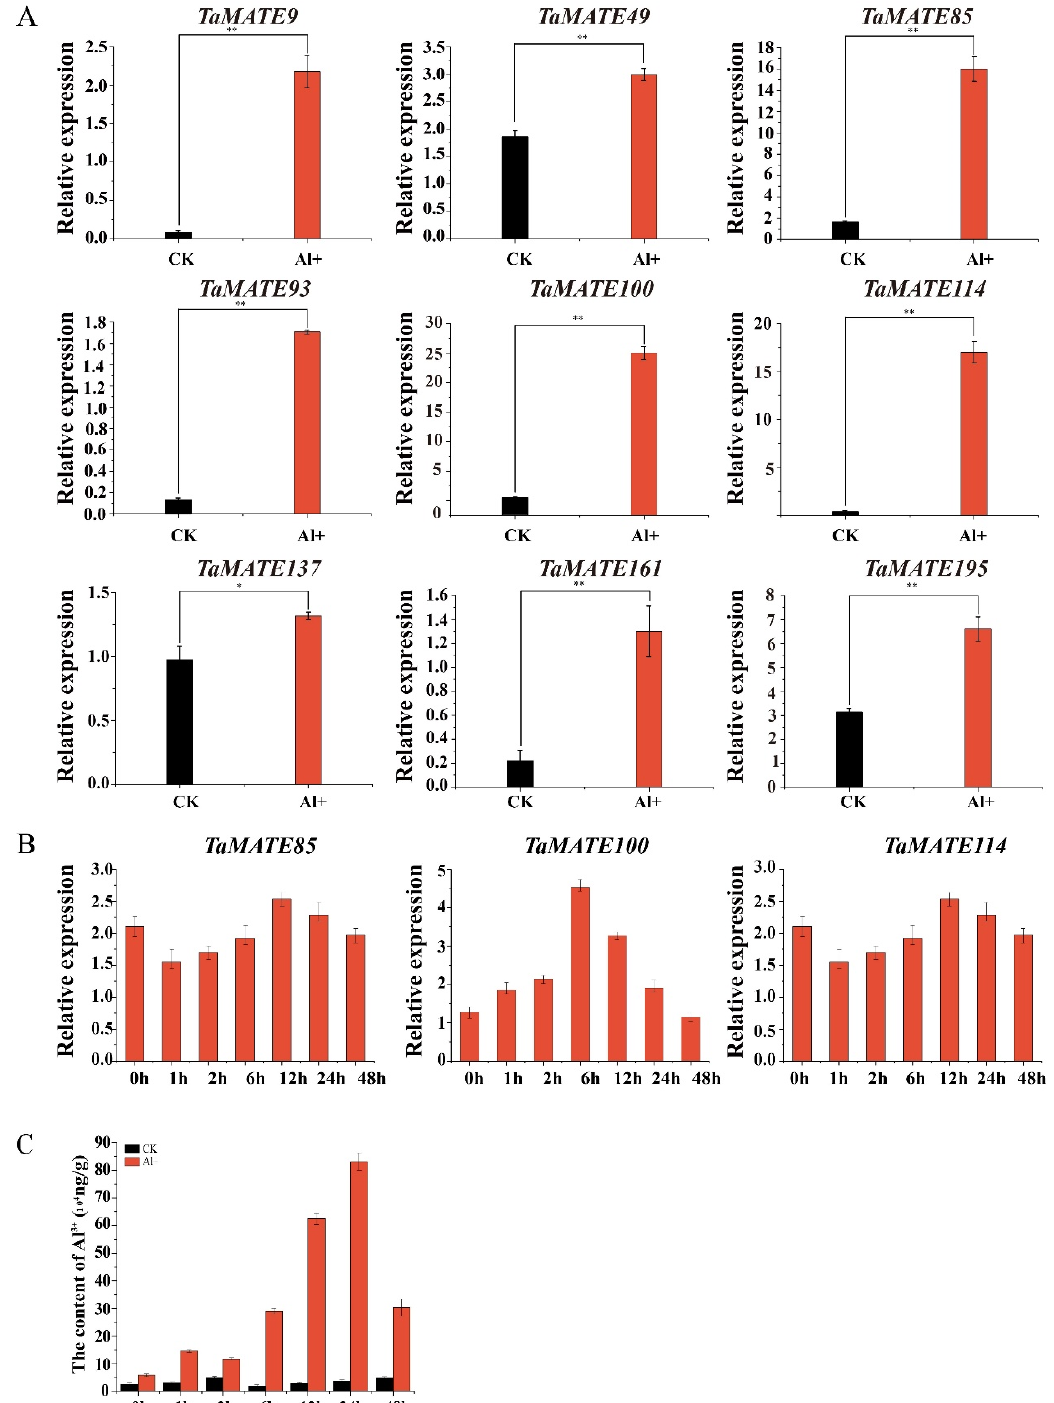
Figure 7. Transcription expression analysis of nine TaMATE genes in root and aluminum content changes from Zhongmai 175 root tips under aluminum (Al 3+ ) stress. ( A ) Transcription analysis of 9 TaMATE genes in root under aluminum stress. Nine TaMATE genes included TaMATE9 , TaMATE49 , TaMATE85 , TaMATE93 , TaMATE100 , TaMATE114 , TaMATE161, TaMATE137 and TaMATE195 . ( B ) Dynamic expression of three TaMATE genes under Al 3+ stress, three TaMATE genes included TaMATE85 , TaMATE100 and TaMATE114 . ( C ) Aluminum content changes of Zhongmai 175 root tips under different times of aluminum stress measured by ICP-MS. *: 0.01 < p < 0.05, **: p < 0.01; the resulting mean values were presented as relative units. Error bar represents Sd.